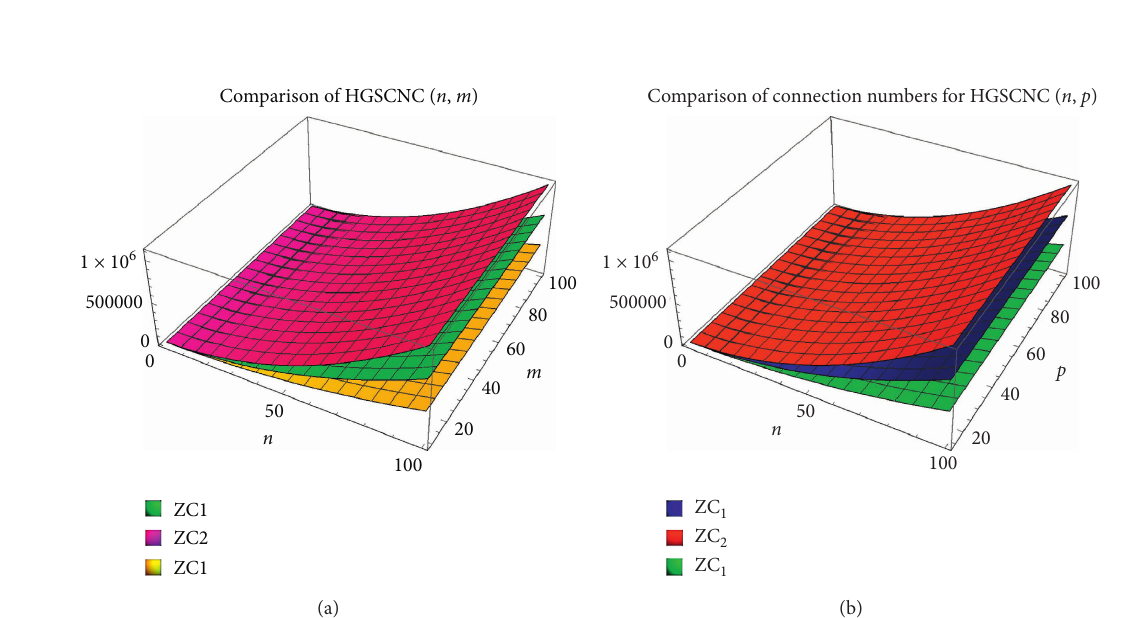
Figure 6: Comparison of connection number for HGSCNC. (a) Comparison of ZC ZC 1 , ZC 2 , and ZC ∗ for HGSCNC ( n, p ) 1